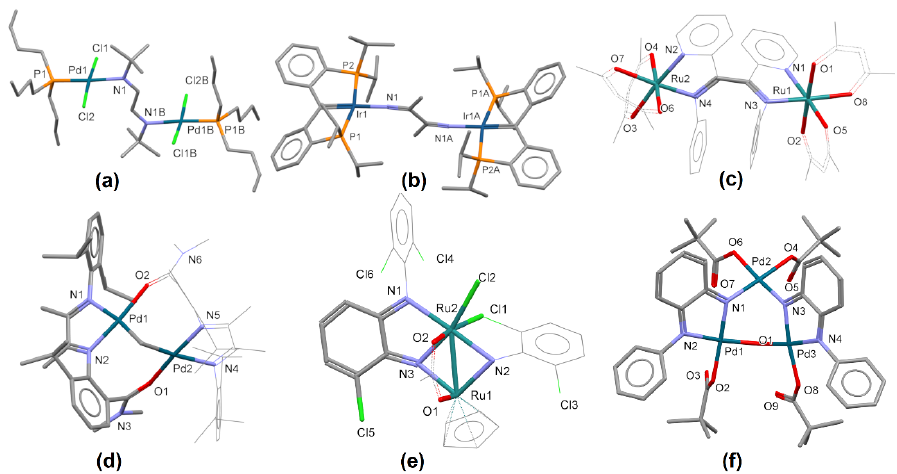
Figure 5. ( a ) A mixed homo- and heterobimetallic palladium-platinum complex with the bridging 4e donor σ , σ - N,N’ coordination mode [132] (CSD Refcode FACKAV); ( b ) butane-2,3-diiminato ligand